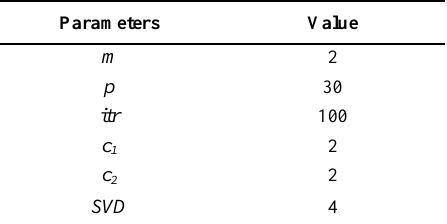
Table 4. The proposed method parameters.